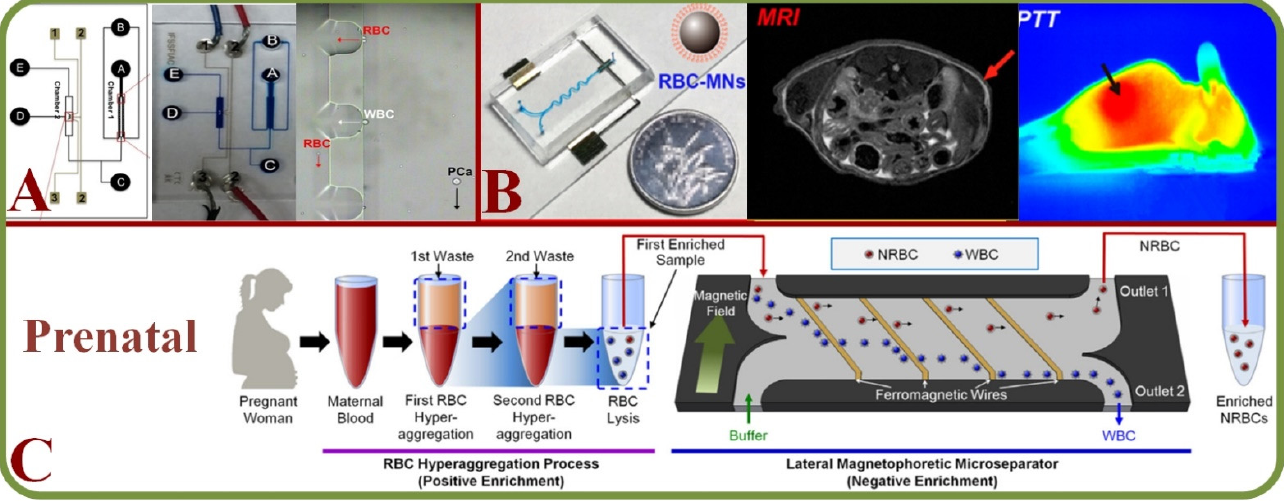
Figure 14. ( A ) Structure and schematic of the microfluidic chip for the isolating prostate cancer CTCs from RBCs and WBCs and single-cell measurement of drug accumulations [239]. ( B ) A microfluidic device for guided cancer therapy with the synthesis of RBCs with membrane-coated magnetic nanoparticles, including the fabricated chip, in vivo tumor MRI with RBC magnetic nanoparticles, and in vivo IR thermal images of a tumor bearing mice [242]. ( C ) A 2-step cascade enrichment procedure for the isolation of nucleated RBCs using enrichment processes based on the RBC hyper- aggregation and lateral magnetophoretic micro-separator